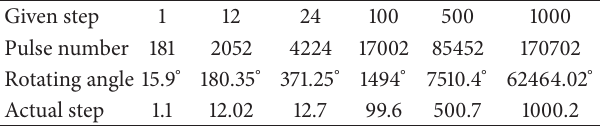
Table1:Experimentdataofpositionprecisionincensementmotion.